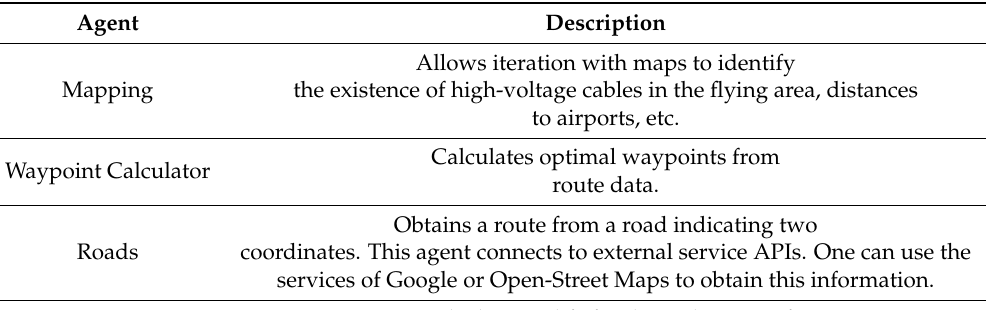
Table 3. Agents of the job/route planning